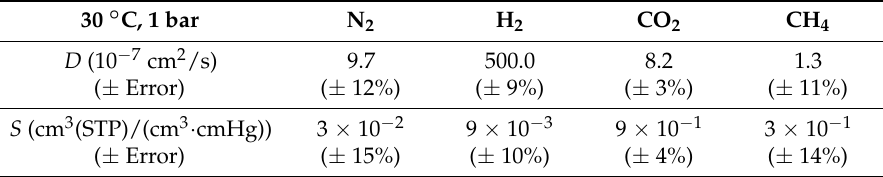
Table 3. Diffusivity and solubility coefficients for MeOH treated film PIM-EA(H 2 )-TB, at 30 °C, 1 bar (Errors calculated by statistical analysis of repeated measurements from separately prepared films).